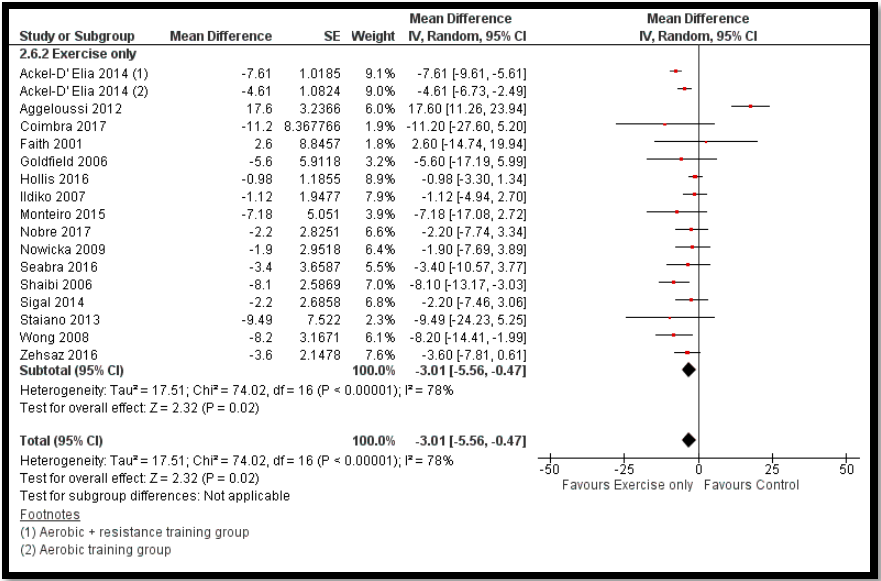
Figure 9. Forest plot for the effect of exercise only interventions for obesity management on body mass index (BMI) .